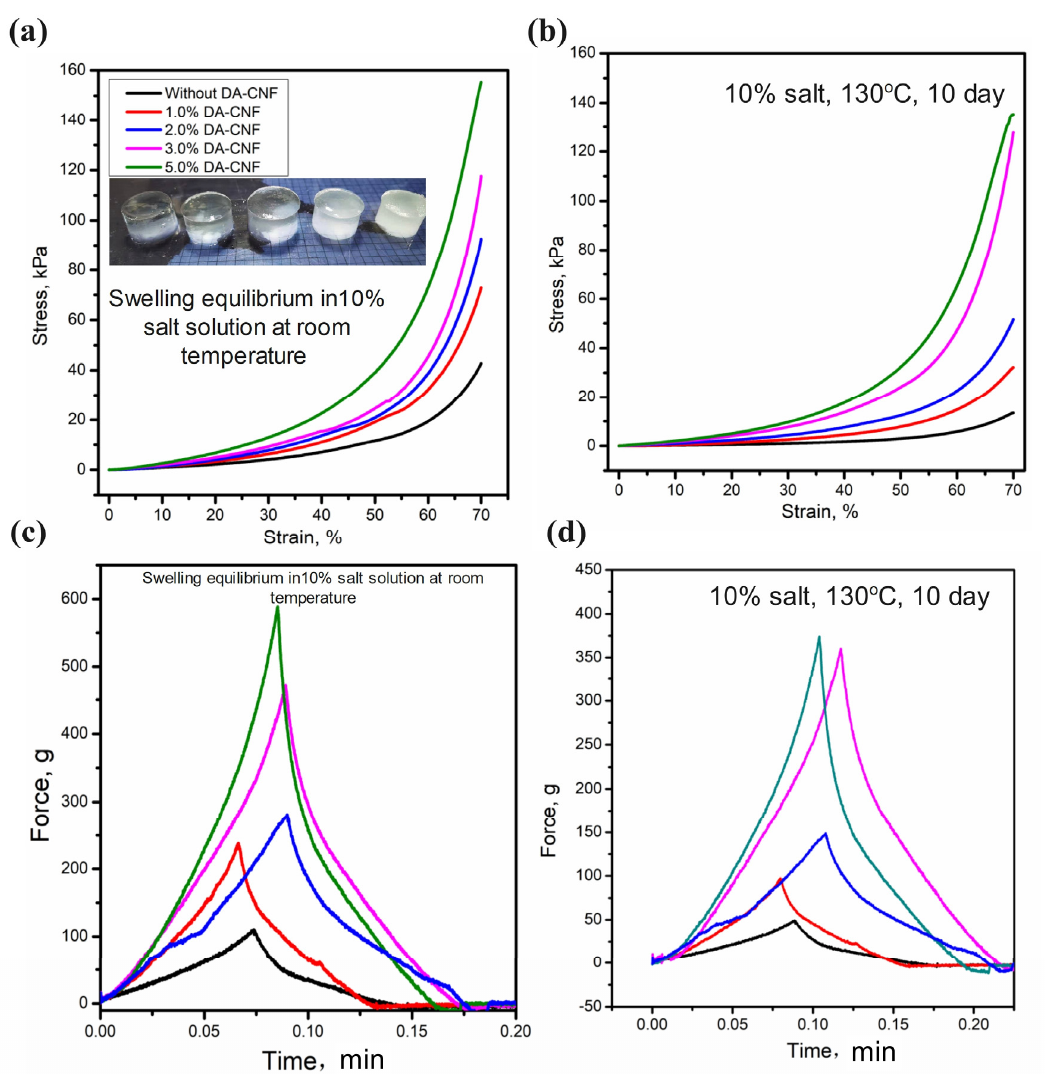
Figure 5. Compressive properties of swelling hydrogels. ( a ) Compressive properties of swelling hydrogels before aging; ( b ) Compressive properties of swelling hydrogels after aged 10 days; ( c ) Bloom strength of hydrogels before aging; ( d ) Bloom strength of hydrogels after aged 10 days.